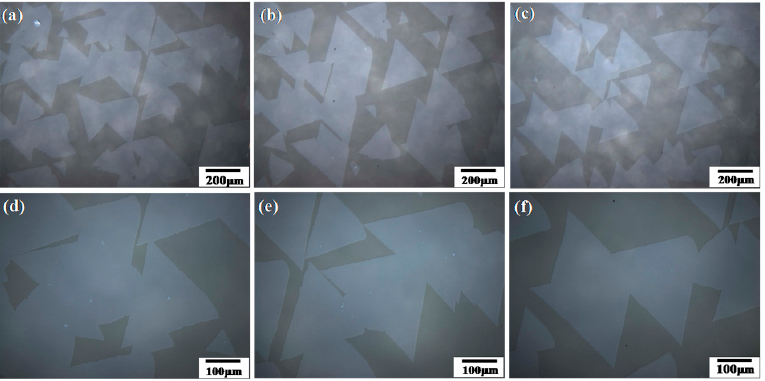
Figure 3. Optical images of the triangles at different locations with different magnifications: ( a – c ) are the images with a magnification of 10×; ( d – f ) are the images with a magnification of 20×.